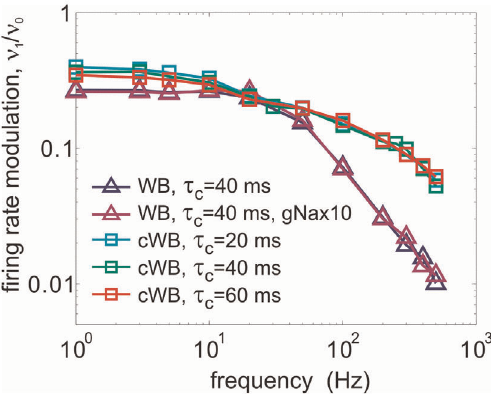
Figure 5. Cooperative channel gating improves the response of a conductance-based model to high-frequency inputs. Frequen- cy response functions for the Wang-Buzsaki model with independent sodium channels and a standard or 10 6 fold increased density density of sodium channels (WB, triangles); for cooperative WB model with 10% of cooperative Na z channels, KJ ~ 1000 mV , measured with 3 different correlation time constants of background noise (cWB, squares).